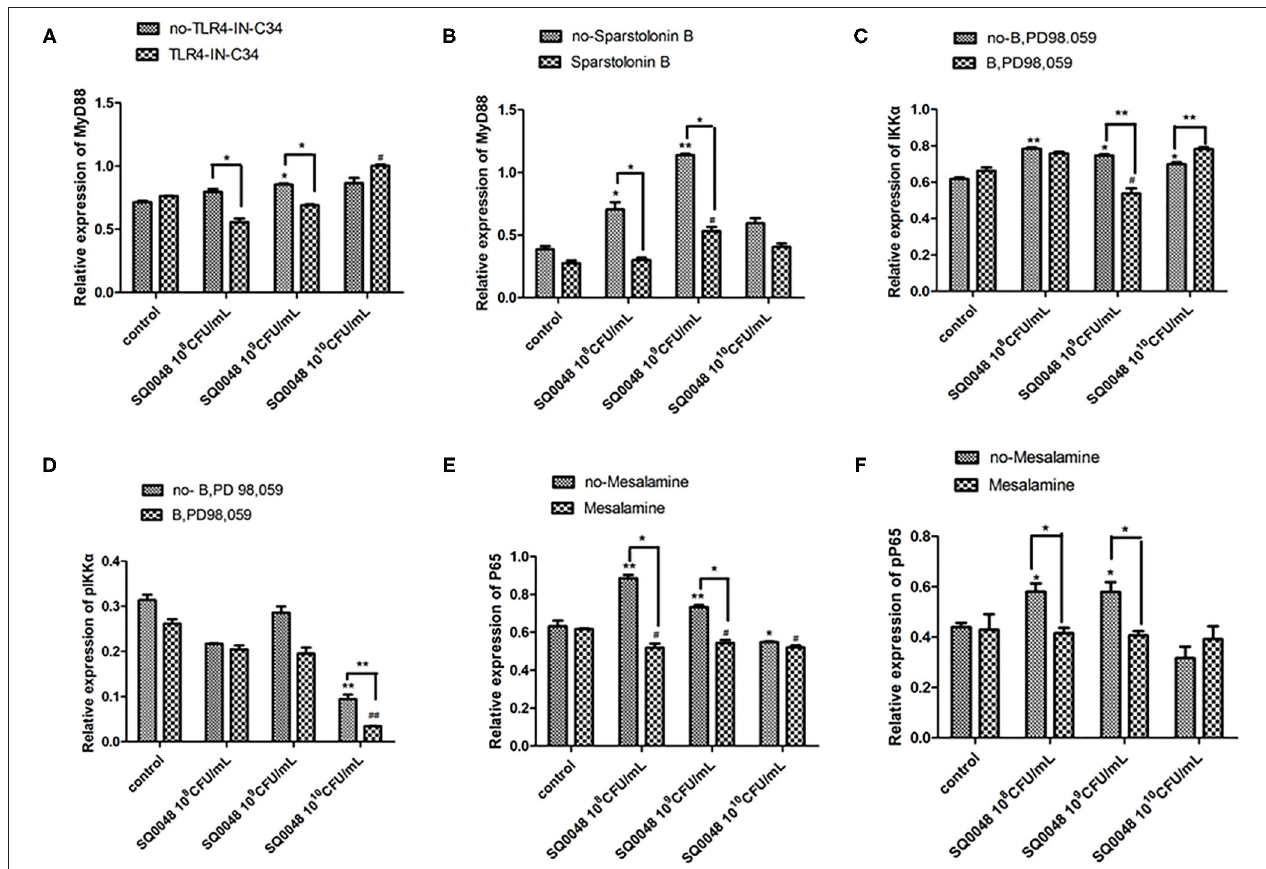
FIGURE 4 | Protein expression levels of MyD88 (A,B) , IKK (C,D) , and NF- κ B (E,F) after treatment with various inhibitors in BVECs using grayscale analysis. Note: TLR4-IN-C34 (A) and Sparstolonin B (B) ; phosphorylated IKK α (C) and non-phosphorylated IKK α (D) in treatment with B,PD98,059; phosphorylated NF- κ B (E) and non-phosphorylated NF- κ B (F) in the treatment by Mesalamine. All data are shown as means ± SD ( n = 3). * or # indicating P < 0.05 and ** or ## indicating P < 0.01. *refers to the comparison between cells in the cell control group not exposed to any treatment and other groups exposed to different concentrations of SQ0048 without inhibitor treatment; it also refers to the comparison between groups without inhibitors and corresponding groups with inhibitors at the same concentration of SQ0048; # refers to the comparison between cells in the inhibitor control group with inhibitors but not SQ0048 and other groups with